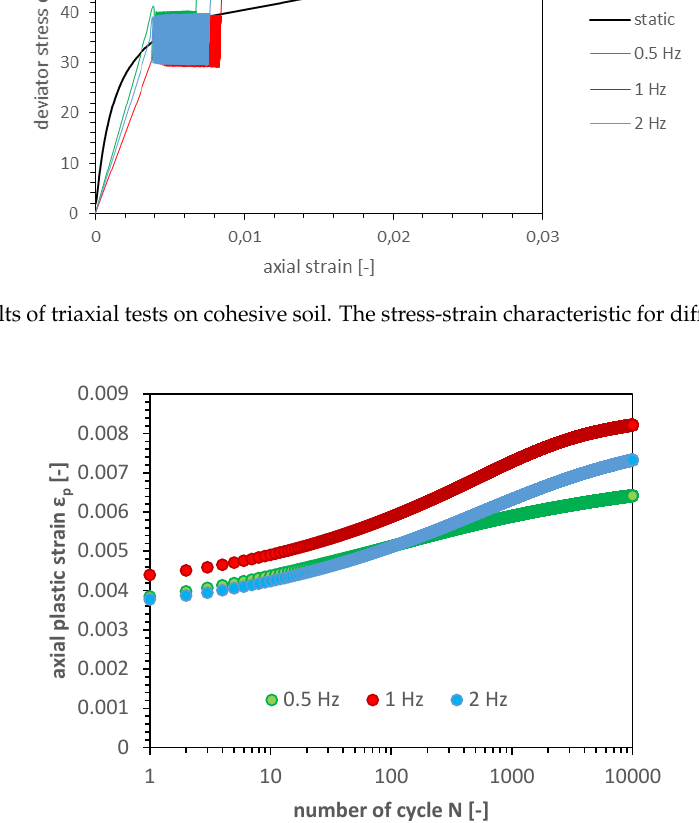
Figure 6. The accumulation of plastic strain characteristics in number of cycles.